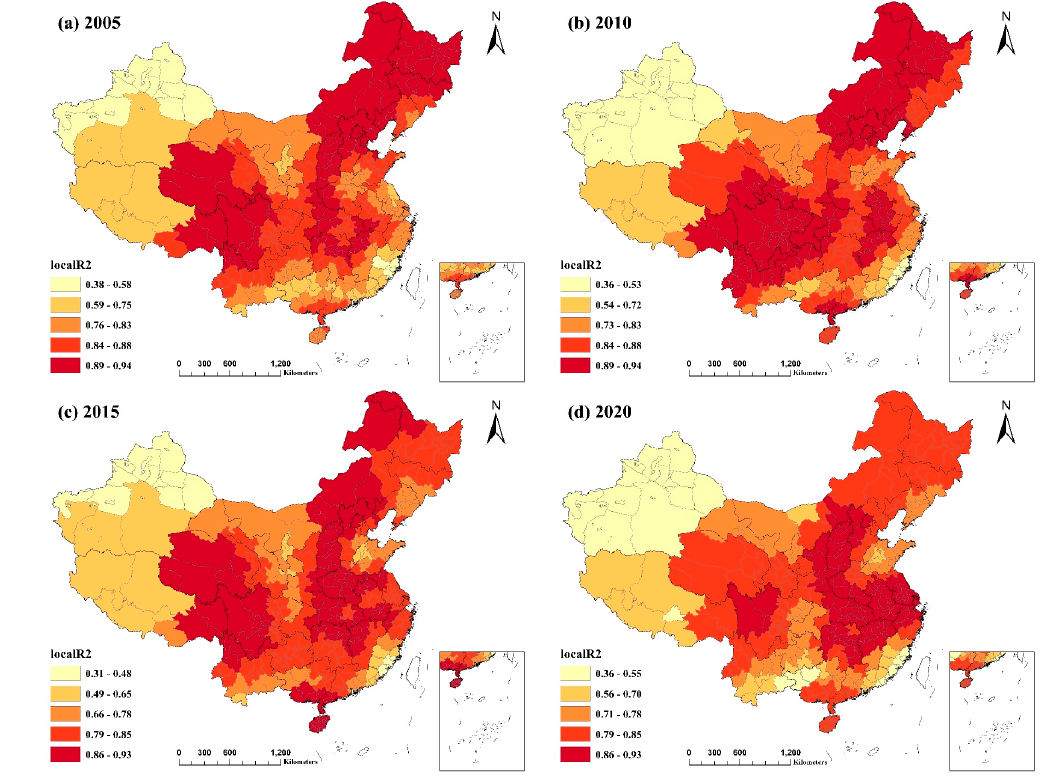
Figure 4. Spatial distribution of local R 2 values for the GWR model from 2005 − 2020: ( a ) spatial dis- tribution of the local R 2 values of the GWR model for 2005; ( b ) spatial distribution of the local R 2 values of the GWR model for 2010; ( c ) spatial distribution of the local R 2 values of the GWR model for 2015; ( d ) spatial distribution of the local R 2 values of the GWR model for 2020.